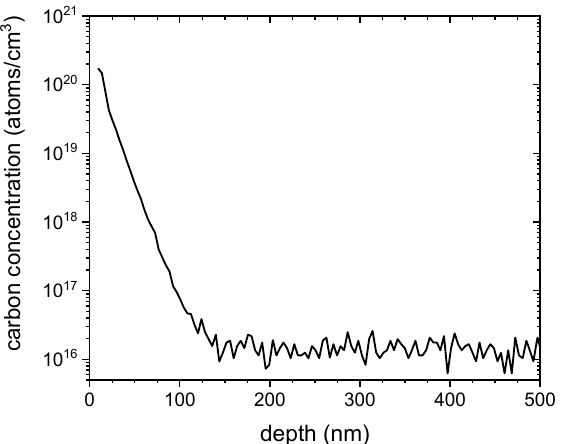
Figure 3. SIMS depth profile of the carbon in the silicon (111) samples used for G-center formation by proton irradiation. The carbon was present in the as-received silicon samples, and there was no carbon ion implantation step.